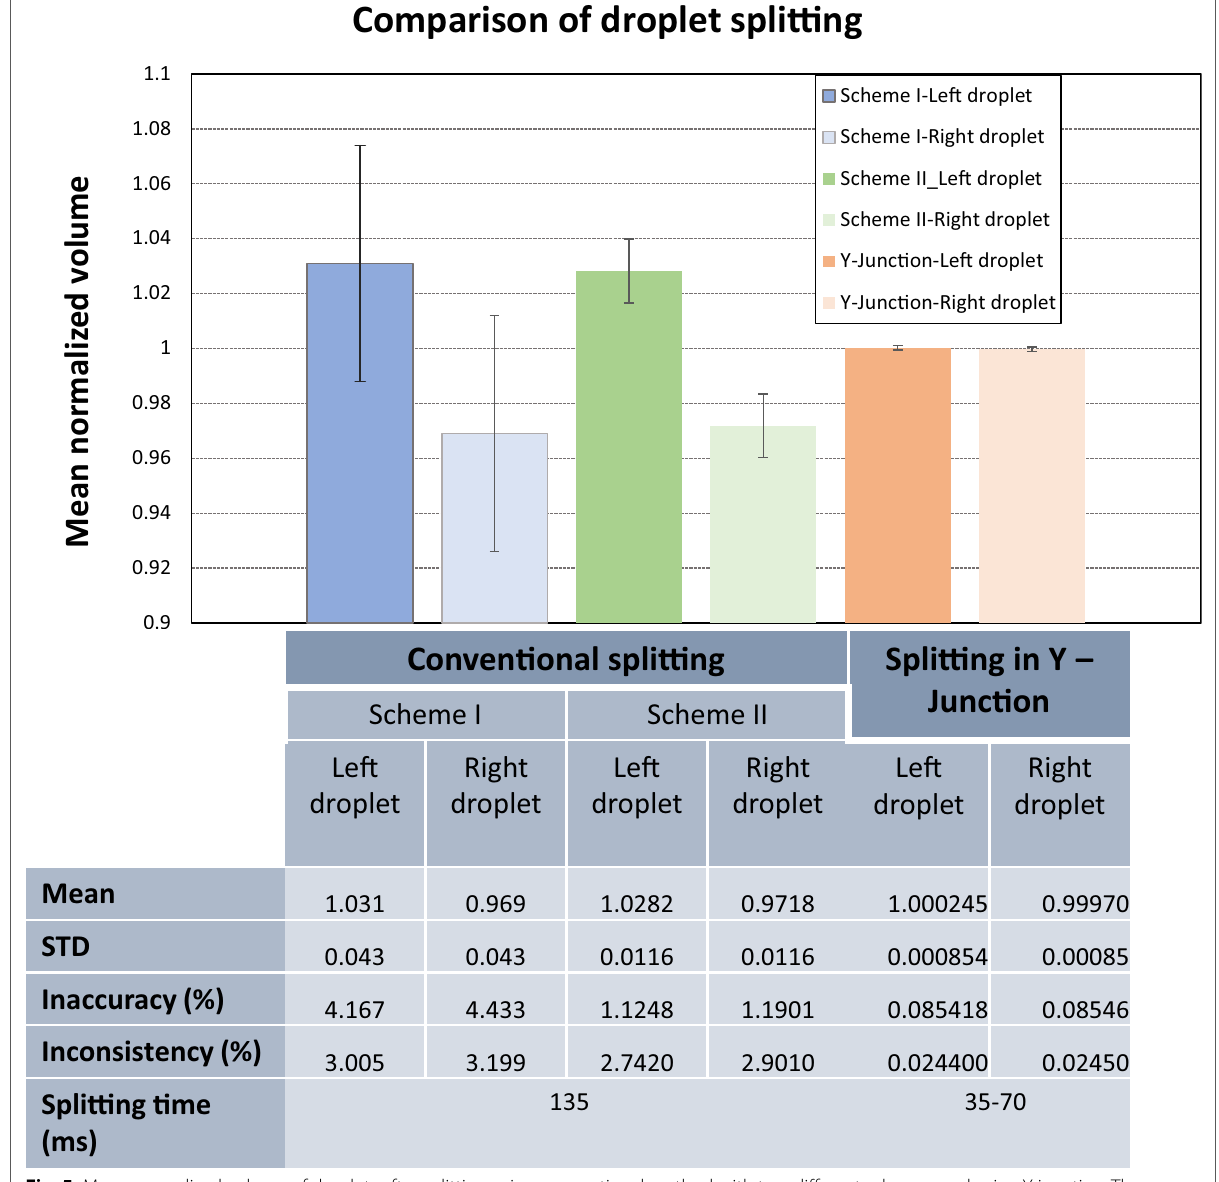
Fig. 5 Mean normalized volume of droplets after splitting using conventional method with two different schemes and using Y-junction. The error bars correspond to the standard deviations. Tabulated values are the summary of tests performed on 10 droplets for all